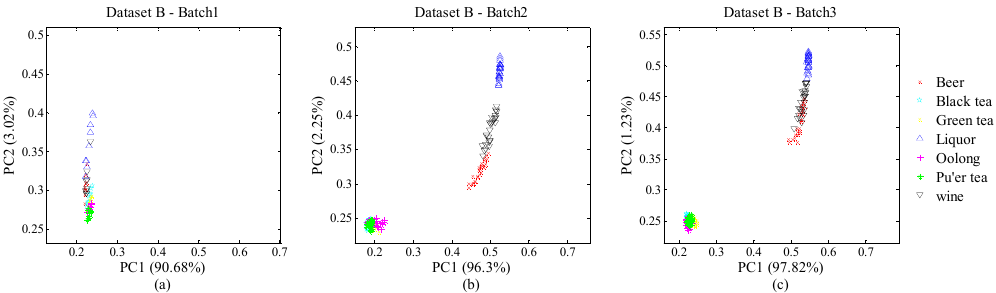
Figure 3. ( a ) Data distribution of Batch 1 of Dataset B; ( b ) Data distribution of Batch 2 of Dataset B; ( c ) Data distribution of Batch 3 of Dataset B.